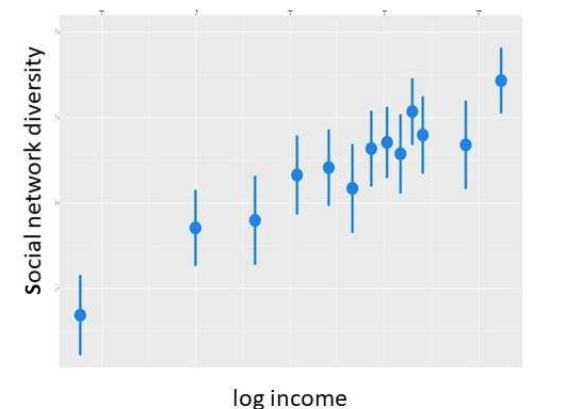
Fig. 1 As individuals’ social networks become more structurally diverse, e.g., they interact with more diverse communities, their income increases [17] . Sample is 100 000 randomly chosen people in mid-income country. Similar results are obtained whether structural diversity is measured by either network clustering coefficient (number of closed triads) or Burt-style measure of structural novelty [8]